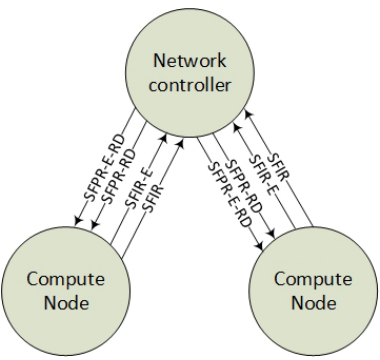
Figure 11. Border Gateway Protocol